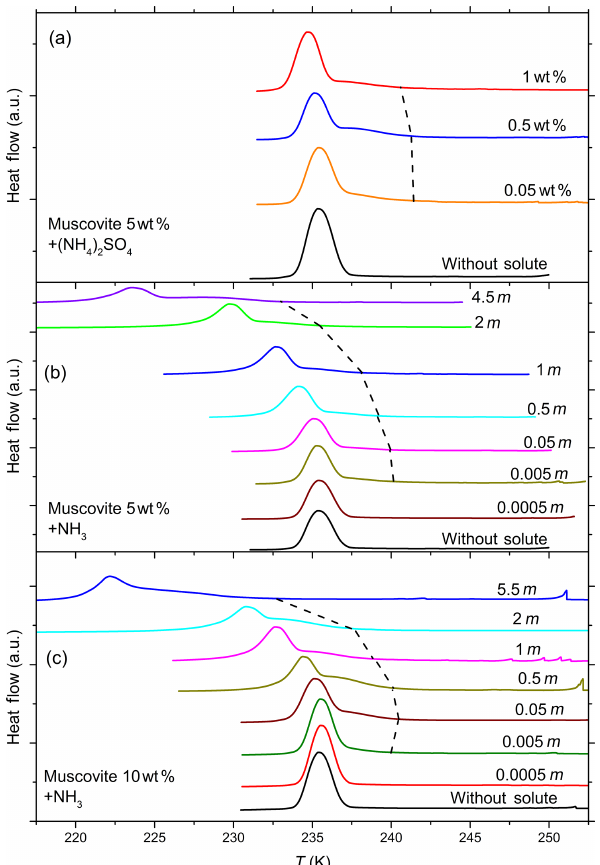
Figure 7. DSC thermograms of 5wt% (a, b) and 10wt% (c) mus- covite particles suspended in ammonia (0–5.5molal; a w equal to 1–0.912) and ammonium sulfate (0–1wt%; a w equal to 1–0.988) droplets of different solution concentrations (given as inserts). All curves are normalized such that the areas under the heterogeneous and homogeneous freezing curves sum up to the same value. The dashed black line connects the heterogeneous freezing onset tem- peratures ( T het ) of the emulsions. With increasing ammonia con- centration heterogeneous IN efficiency starts to develop, as can be noticed from the appearance of T het , which was absent in pure wa- ter. The intensity of the heterogeneous freezing signal, hence F het , becomes more prominent in 10wt% suspensions (see Table 1).